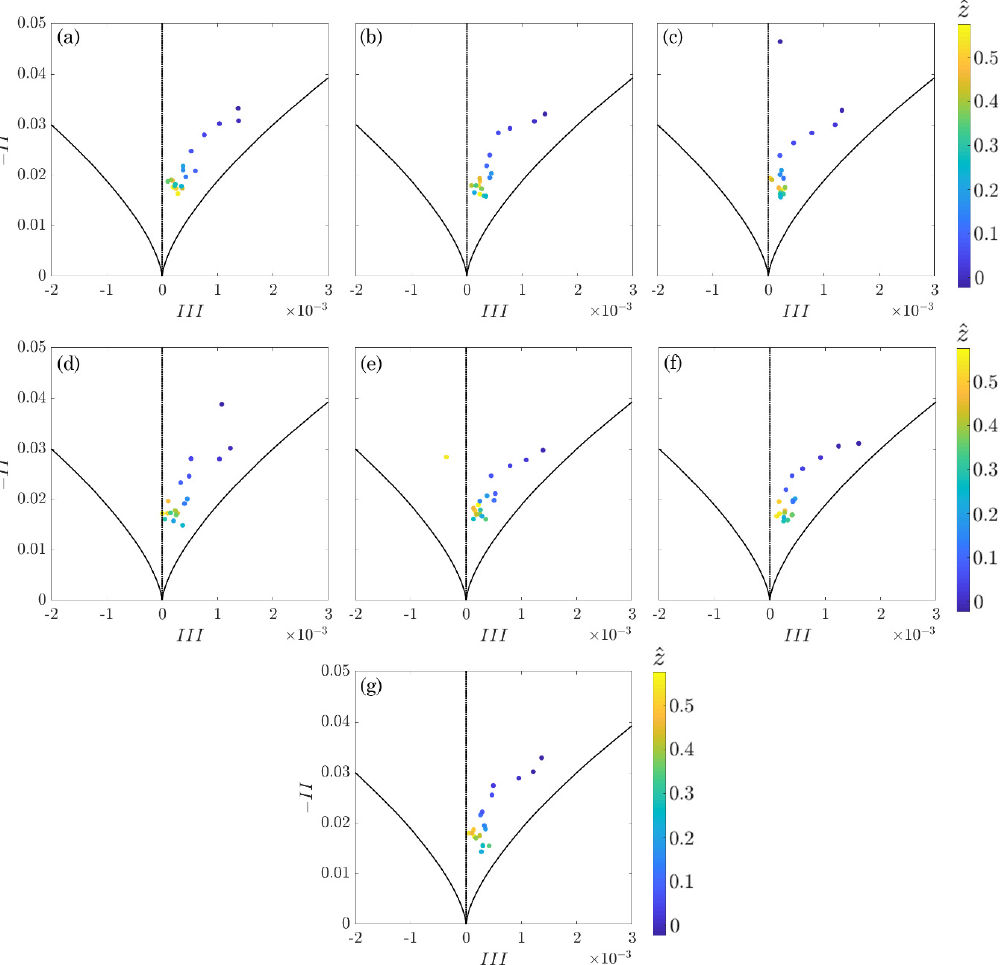
Figure 9. AIMs of Run 3 at ( a ) x / L s = 0, ( b ) x / L s = 0.17, ( c ) x / L s = 0.33, ( d ) x / L s = 0.50 (at the vegetation stem axis), ( e ) x / L s = 0.67, ( f ) x / L s = 0.83, ( g ) x / L s = 1.00.